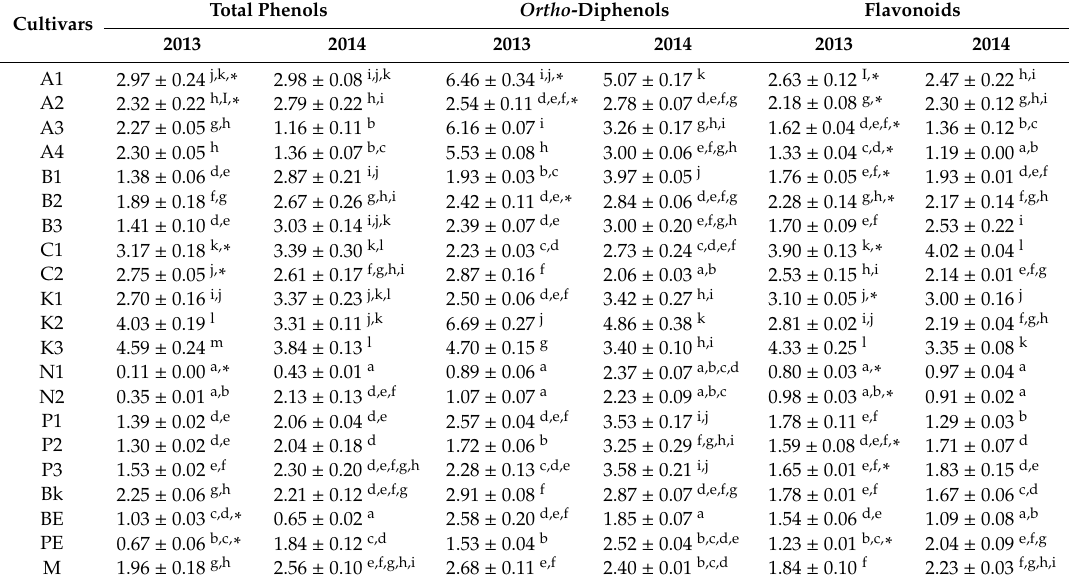
Table 1. Total phenols (mg GAE / g dw), ortho -diphenols (mg GAE / g dw), and flavonoids (mg CE / g dw) of 10 common bean cultivars for 2013 and 2014 harvest years, grouped according to their morphological characteristics. Cultivars: Arikara yellow (A1, A2, A3, A4), butter bean (B1, B2, B3), cranberry (C1, C2), red kidney (K1, K2, K3), navy (N1, N2), pinto (P1, P2, P3), black (Bk), brown eyed (BE), pink eyed (PE), and tarrestre